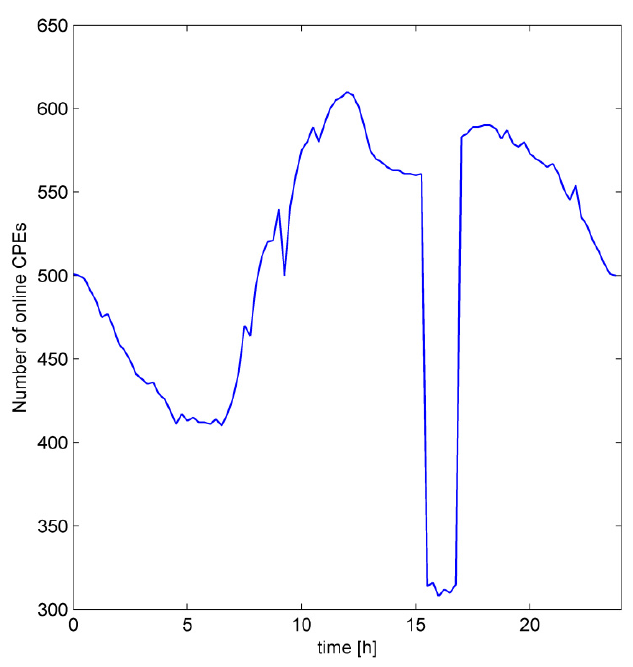
Figure 4. Number of online users.